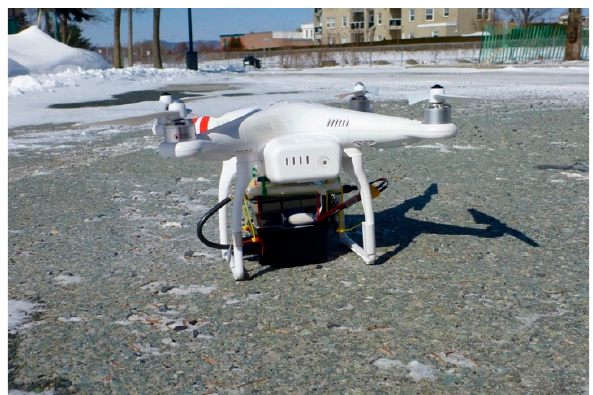
Figure 8. Radar system mounted under a Phantom 2 remotely piloted aircraft (RPA) quadcopter.